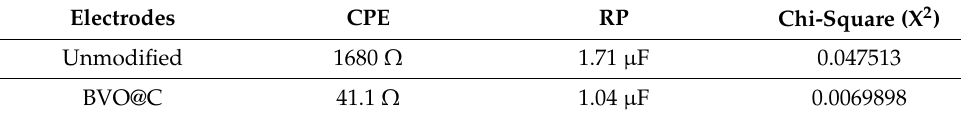
Table 2. Comparative EIS between unmodified electrodes and BVO@C